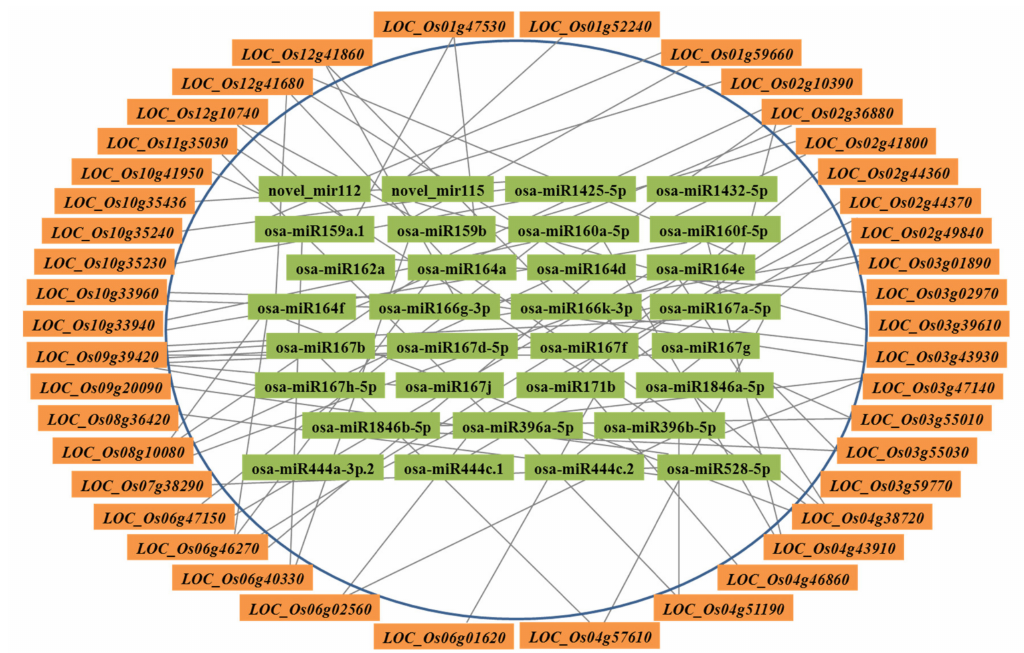
Figure 5. The Xoo -responsive regulatory units of miRNA / targets in infected rice plants. Numbers in internal block with light green color were miRNAs. The genes in outer block represent the targets for the counterparts in the